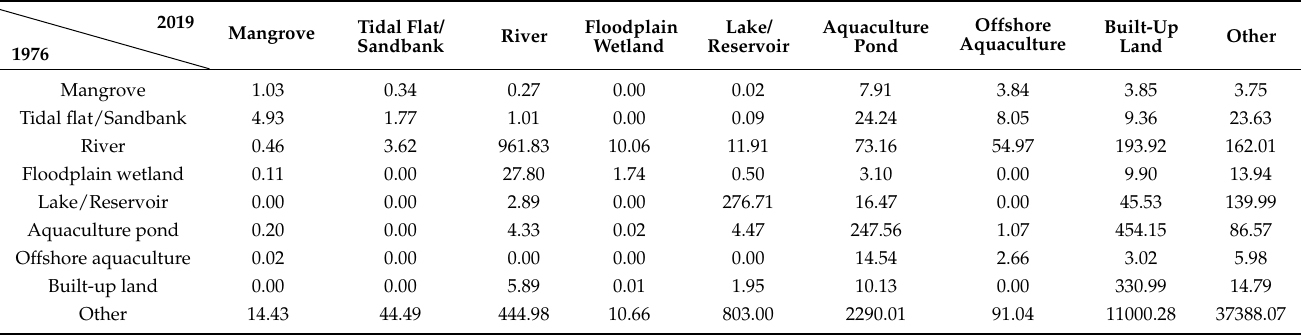
Table A5. Transfer matrix of each land cover type in the GBA from 1976 to 2000 (km 2